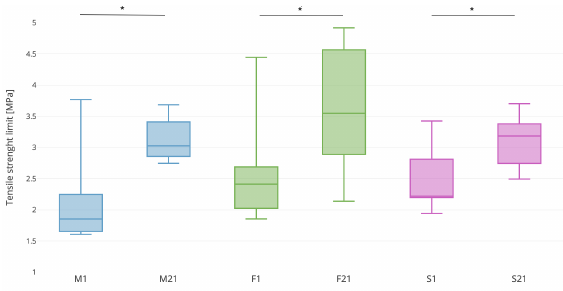
Figure 6. Box plot comparing the tensile strength limit of 1 (M1) and 21 (M21) of the day of samples exposed in medium, F1 and F21 of Fibroblast samples, 1 (S1) and 21. day (S21) of osteoblast specimens, * indicates statistically significant differences (Mann- Whitney, 0.05)